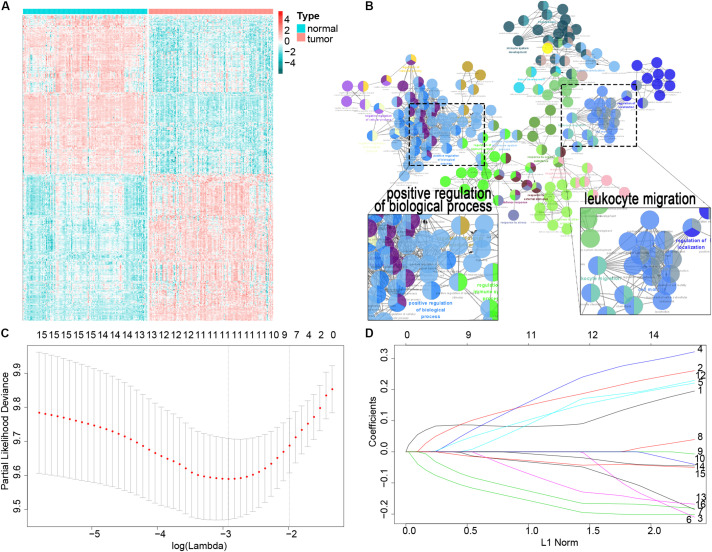
Filter out the most prognostic candidates from the differentially expressed immune-related genes in ESCC. (A) Heatmap of differentially expressed immune-related genes between ESCC and adjacent normal tissues. (B) GO analysis in Cytoscape of these differential genes. (C) One-hundred-fold cross-validation for tuning parameter selection in the LASSO model. (D) LASSO coefficient profiles of the most useful prognostic genes.